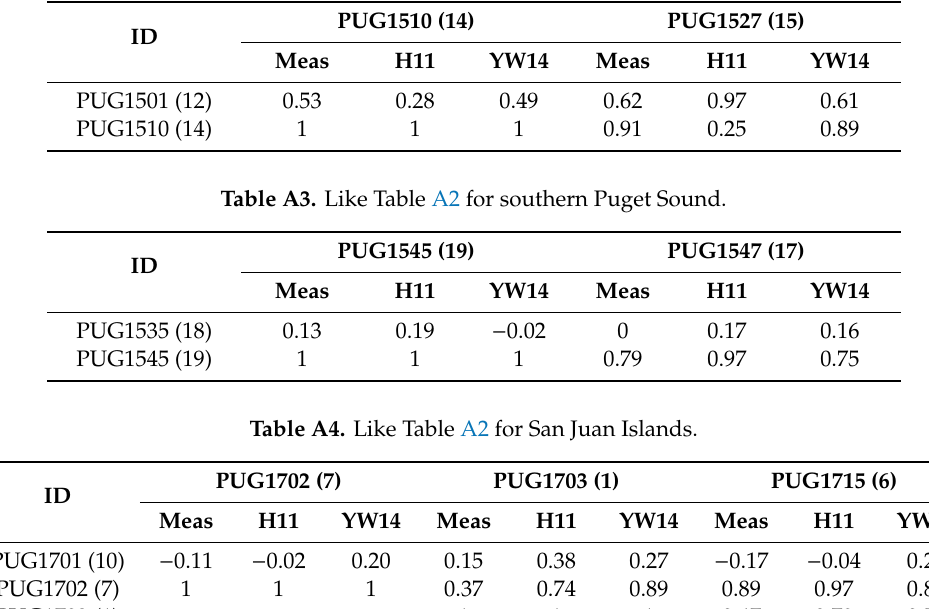
Table A2. Cross-correlation verification for central Puget Sound. Meas stands for measurements.